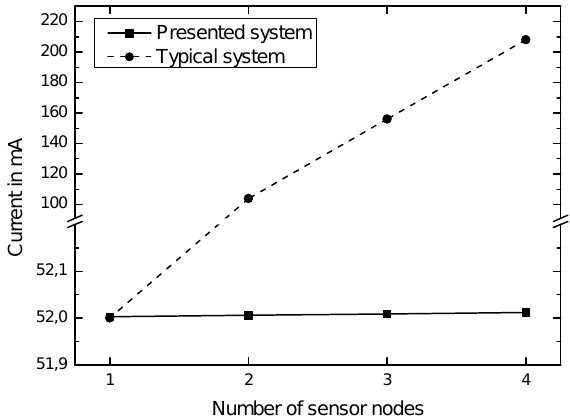
Figure 8. Comparison of a network with Wi-Fi nodes against a network with SmartGate and nodes with wake-up